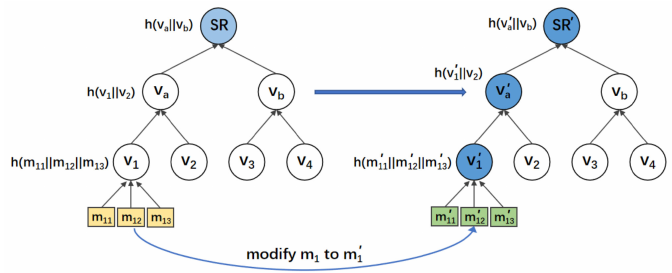
Figure 5. An example of data block m 1 being modified to m (cid:48)